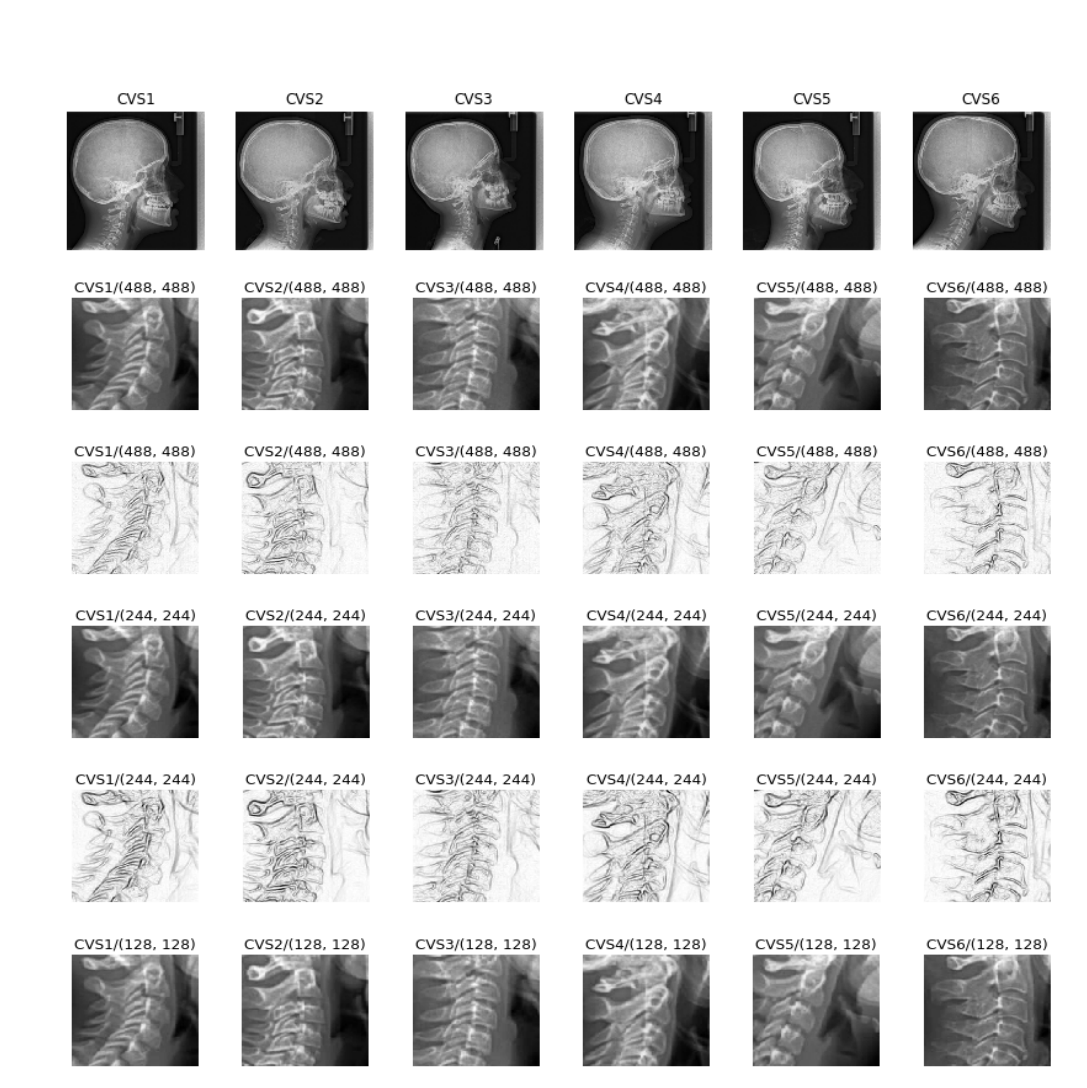
Figure 2. Originals and different preprocessing before training: ( a ) Originals (2012 × 2020), ( b ) test0: cropped images (488 × 488), ( c ) test1: cropped and sobel edge detector filter (488 × 488), ( d ) test2: cropped and resized (244 × 244), ( e ) test3: cropped, resized and sobel edge detector filter (244 × 244), ( f ) test4: cropped and resized (64 ×